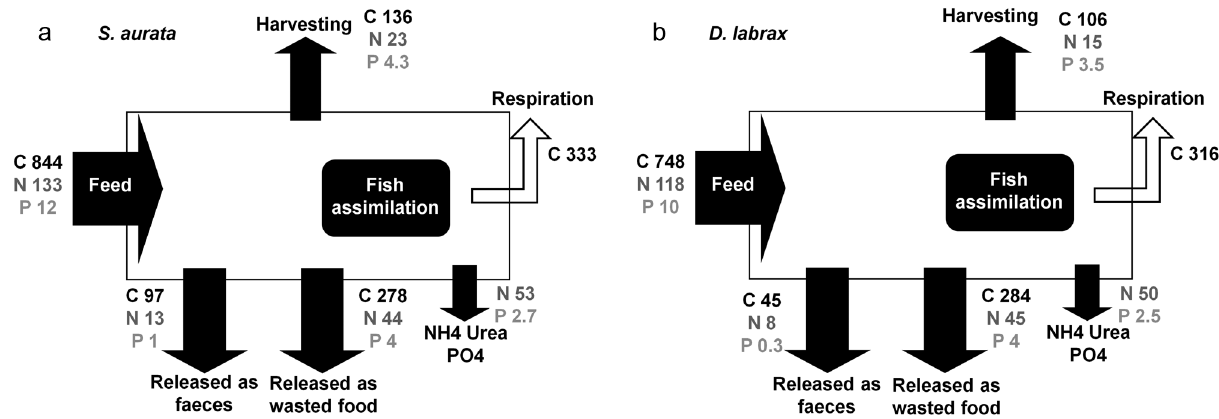
Fig. 9. Sparus aurata (a), Dicentrarchus labrax (b). Estimates of C, N and P fluxes (kg), per 1 ton of fish produced, exchanged between the different reservoirs (feed, fish, environment) over the whole simulated